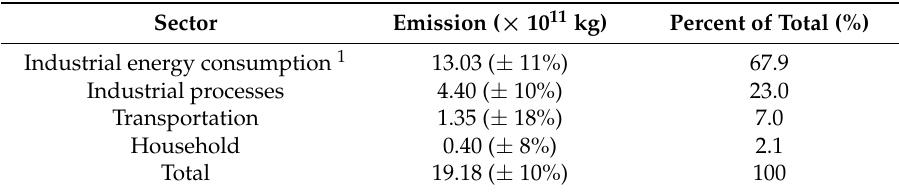
Table 1. Anthropogenic CO 2 emissions in the YRD in 2012.